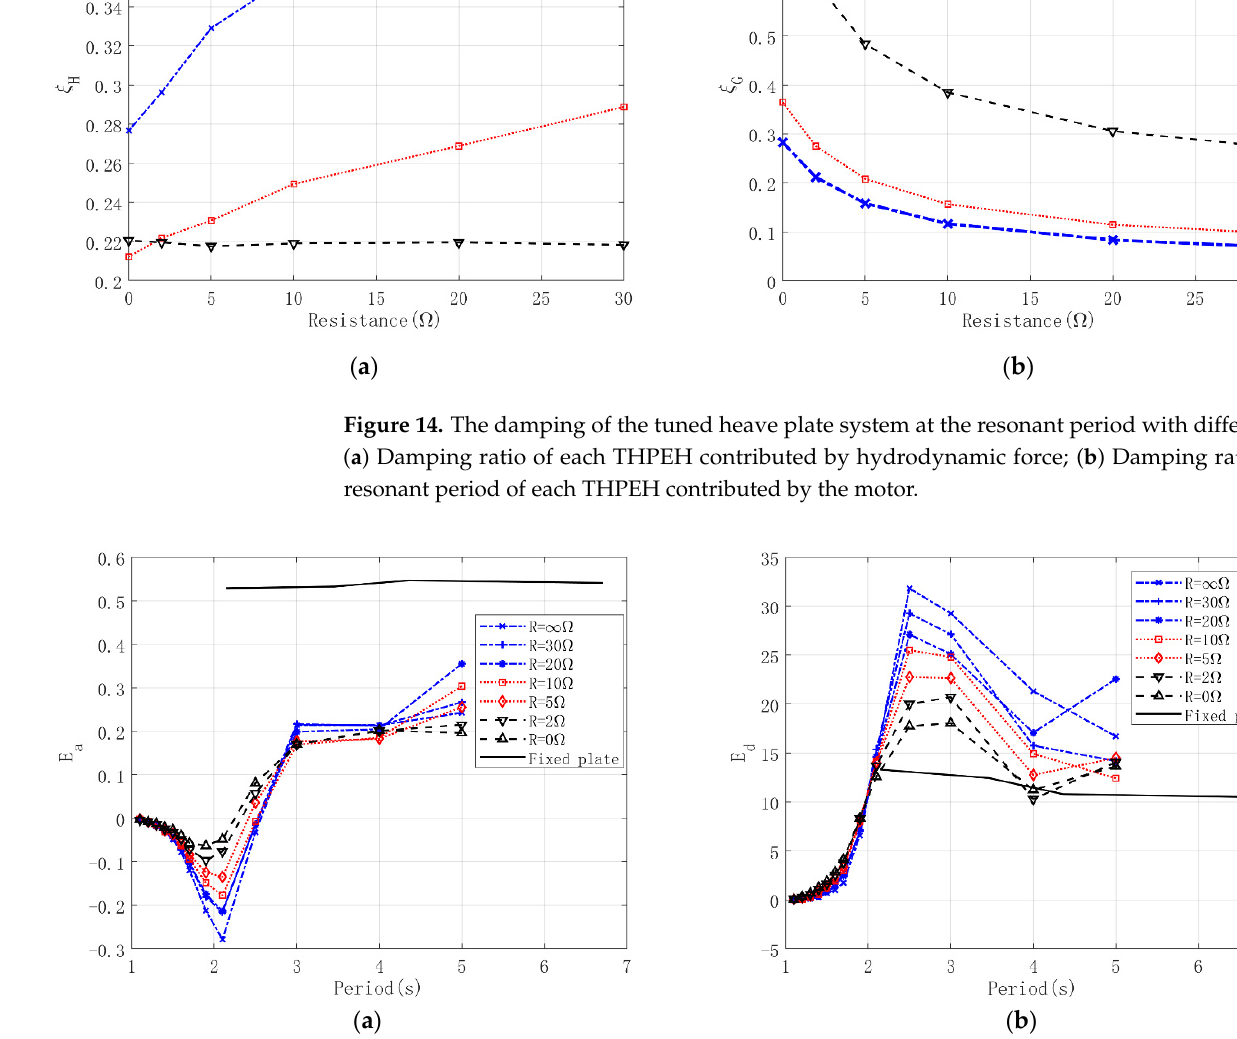
( b ) Figure 16. The equivalent hydrodynamic parameters of THP2 with different load resistance. ( a )